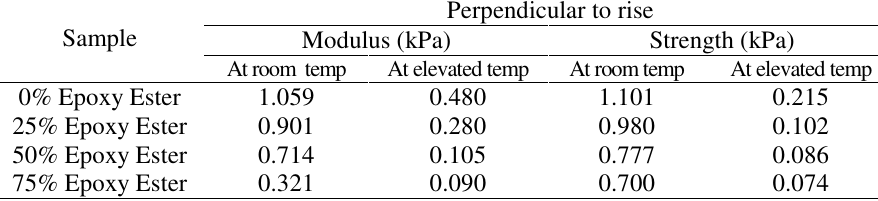
Table 3 . Compressive modulus and strength perpendicular to